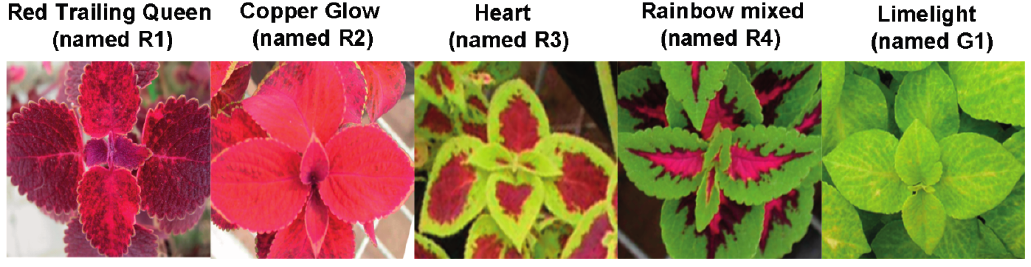
Figure 1. Five Coleus ( S. scutellarioides (L.) Codd) lines in this study. R, red; G, green. The full-length cDNA is 2356 bp, containing a 95-bp 5 ′ -UTR, a translation start site for eukaryotic genes (ATCATGG), a 2136-bp ORF encoding a 711-amino acid protein and a 125 bp 3 ′ -UTR,